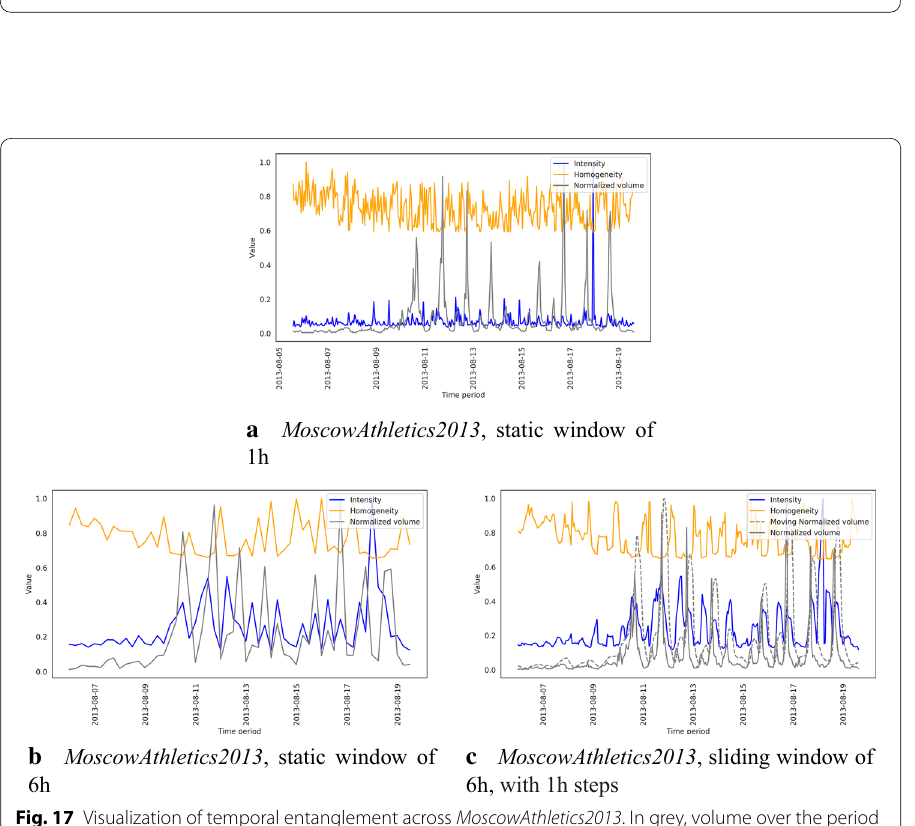
Fig. 17 Visualization of temporal entanglement across MoscowAthletics2013 . In grey, volume over the period of time (dotted line for the aggregated volume over sliding window ( c )). Intensity in blue and